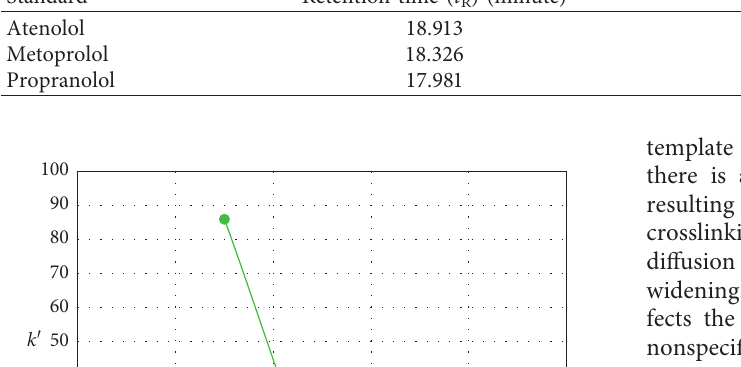
Table 4: Chromatographic profile of the imprinted monolithic column using the mobile phase acetonitrile. Standard